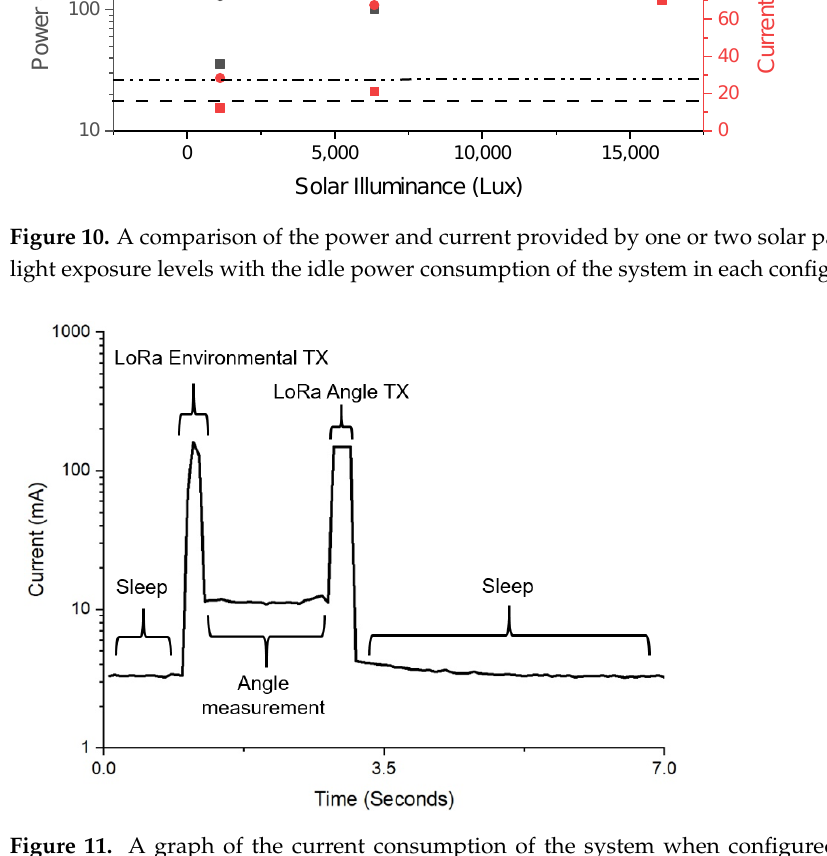
Figure 11. A graph of the current consumption of the system when configured for measuring bivalve activity.